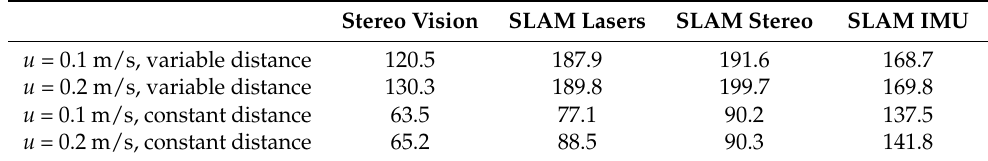
Table 4. Integral of absolute error for distance-from-the-bottom control.